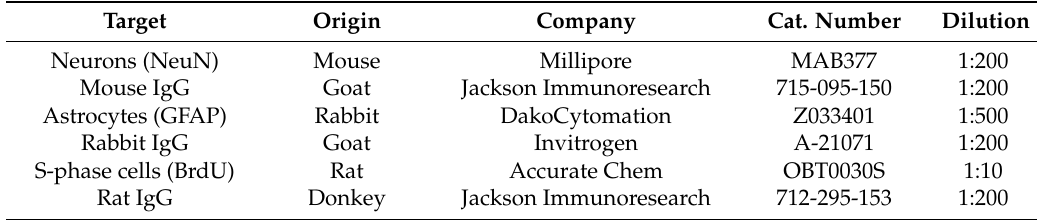
Table 1. Primary and secondary antibodies used in this study.